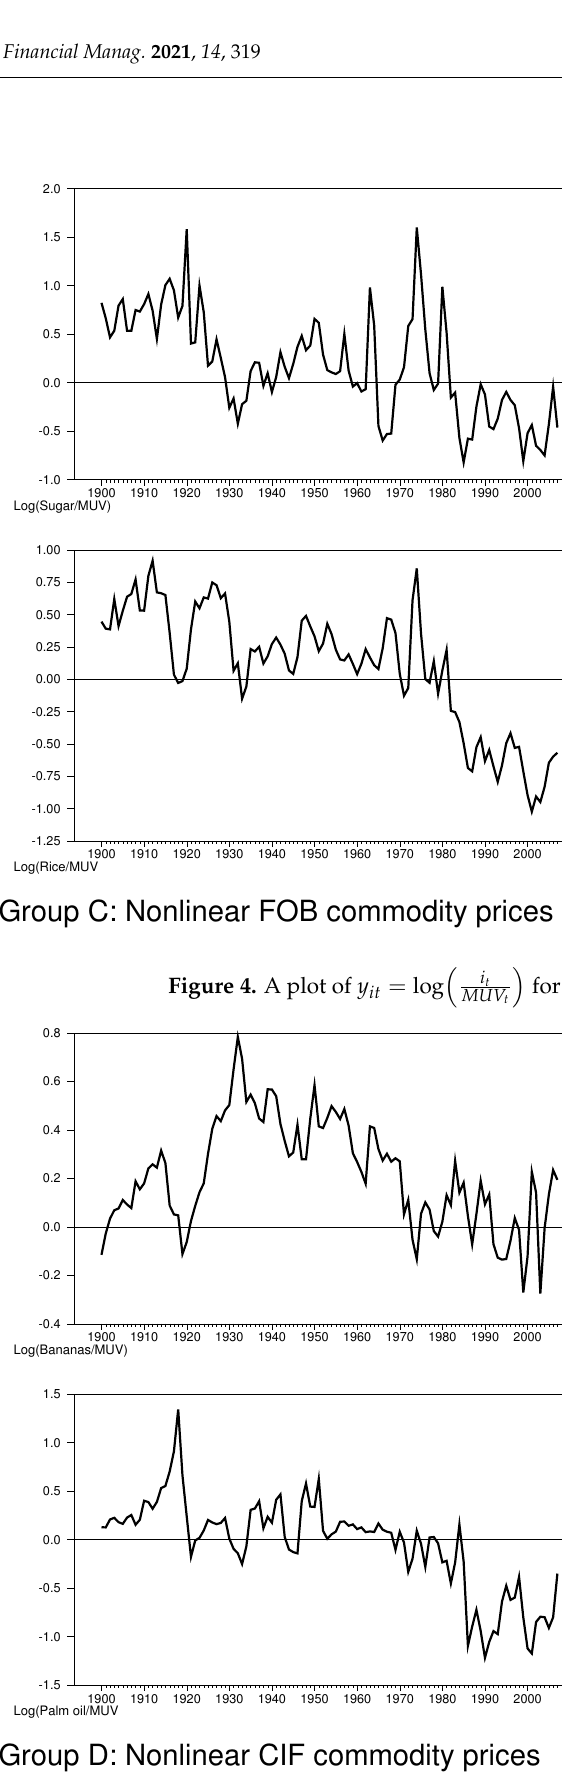
(cid:16) (cid:17) i t for every commodity price i in Group D in Table MUV t